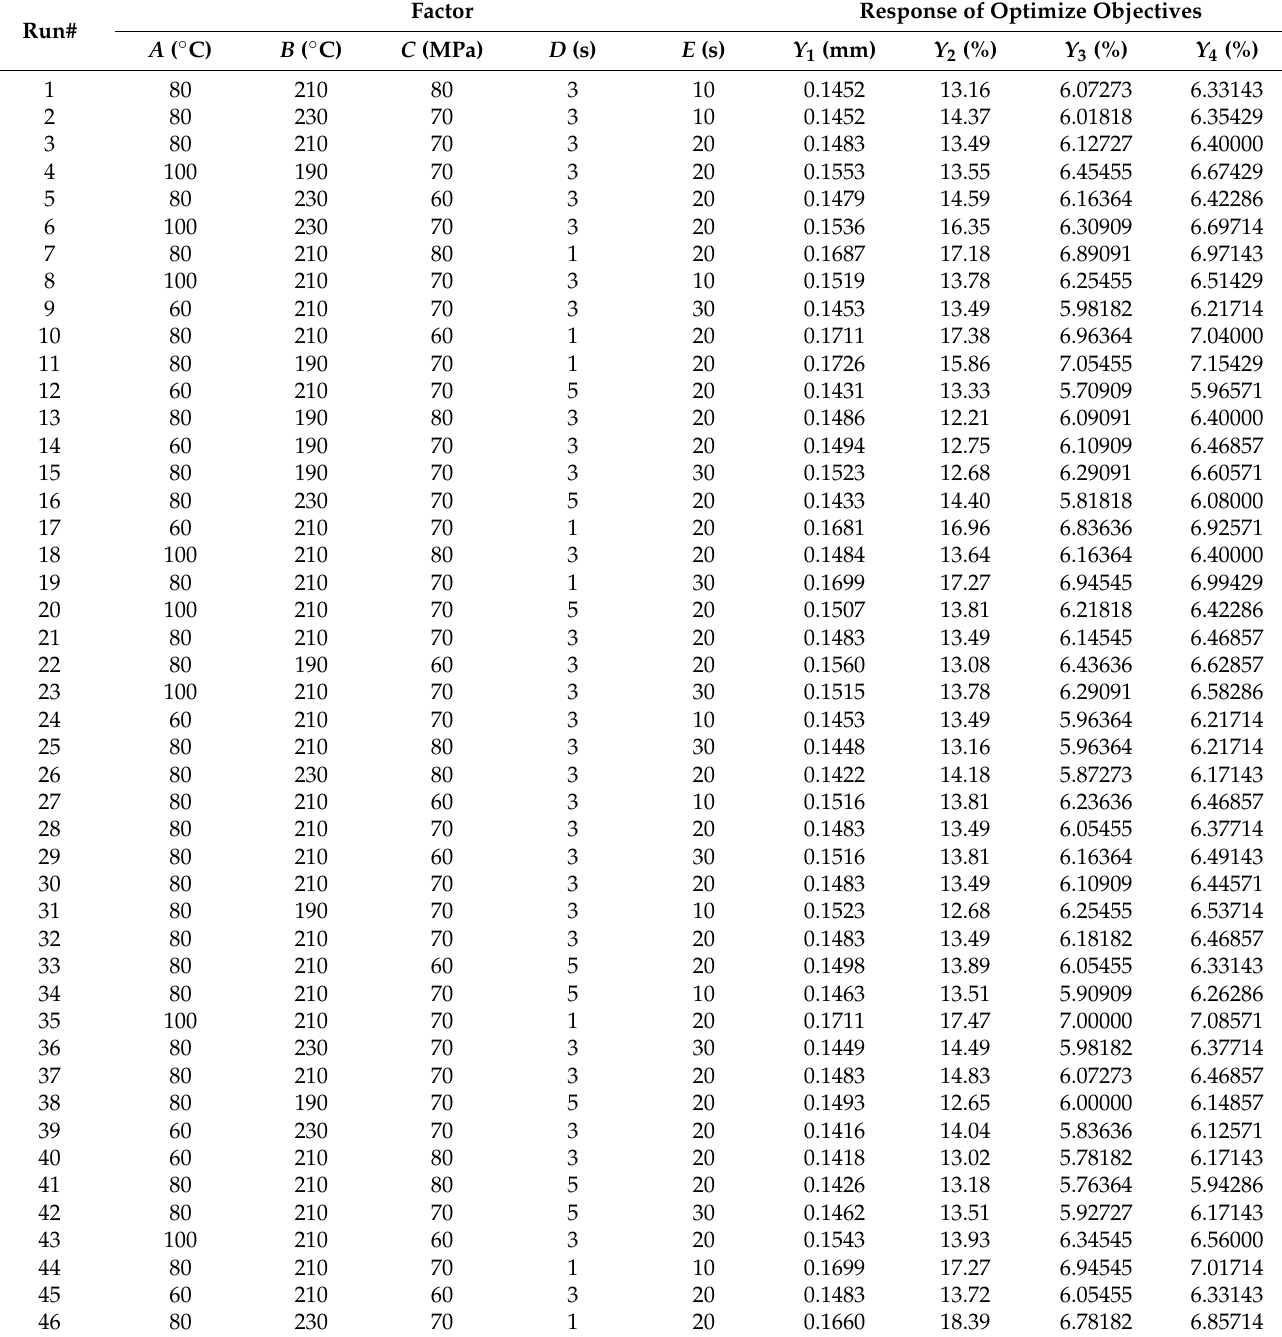
Table 3. Box–Behnken experimental design and simulation